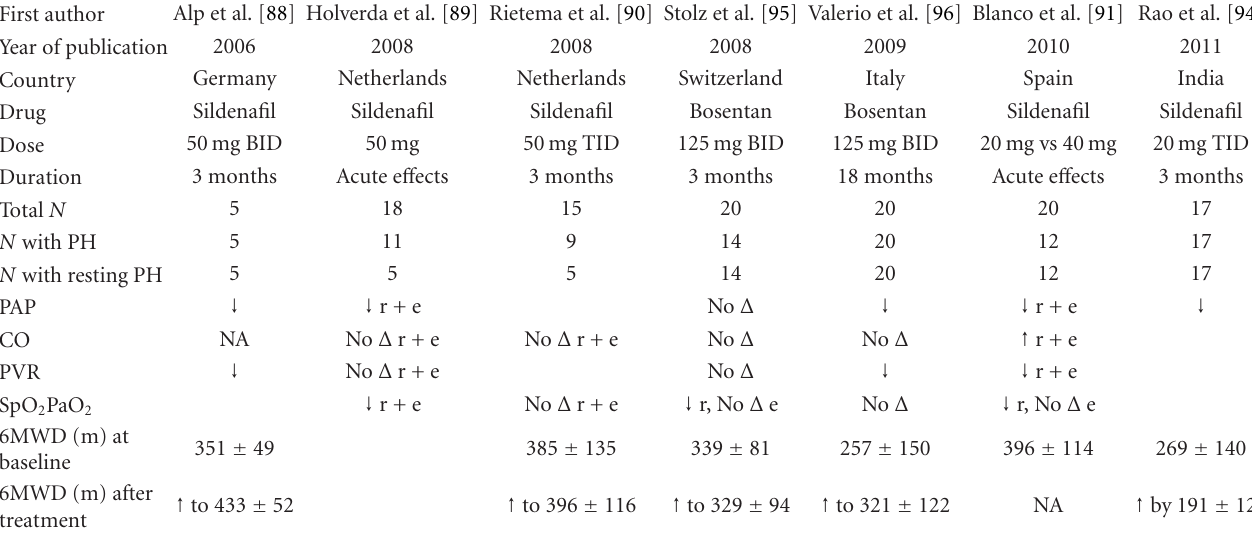
Table 6: Summary of the e ff ects of pulmonary vasodilators in the published studies of such drugs in COPD patients.